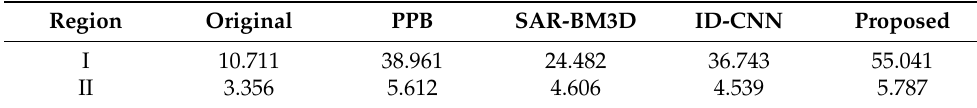
Table 6. The estimated ENL results for the Death Valley SAR image.